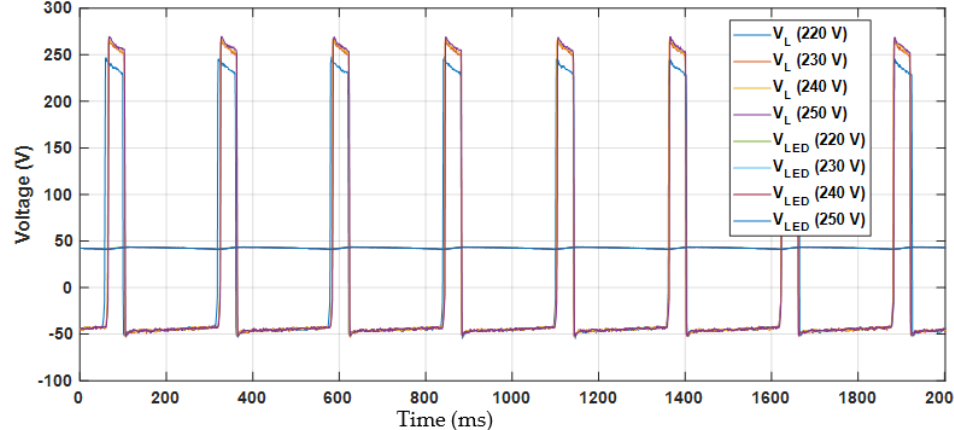
Figure 15. The voltage across the reactance (V L ) and the voltage across the LEDs (V LED ) for four different mains voltages, Type B lamp.